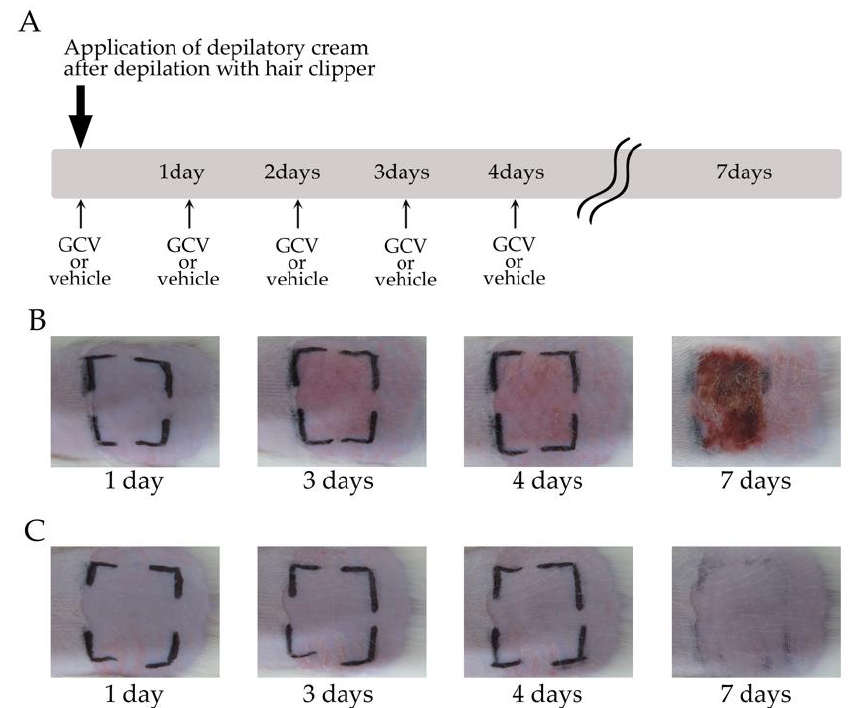
Figure 4. Selective ablation of NG2 + HFSCs during the depilation-induced anagen phase aggravated contact dermatitis with treatment of a depilatory cream. ( A ) Schematic of the experimental protocol. The bold arrow indicates depilation with a hair clipper and application of the depilatory cream. Arrows show application of GCV or vehicle to defined area (black lines) of the Tg rat skin. GCV, ganciclovir. ( B , C ) Photographs of GCV-applied ( B ) and vehicle-treated ( C ) skin of Tg rats at 1, 3, 4, and 7 days after the first application following treatment of the depilatory cream. Table 1. Contact dermatitis is induced by selective ablation of NG2 + HFSCs with depilatory cream.